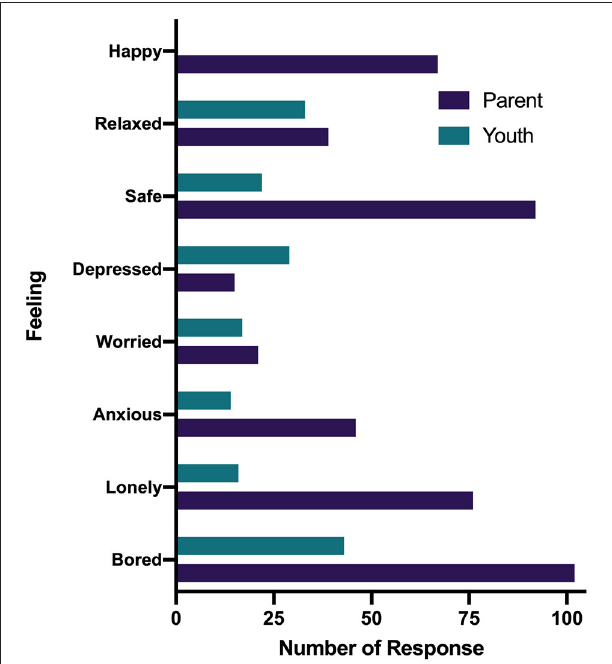
Parents and youth reported their level of agreement with ( Table 2 ). The distribution of responses between parents and youth was different for each question ( p < 0.05), though absolute differences in proportions were minimal for some questions.